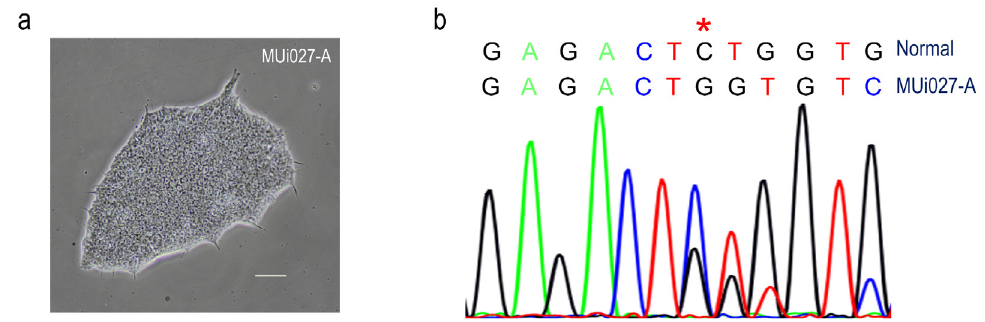
Figure 1. Generation of iPSC lines from ADPKD patient. ( a ) Representative bright field photograph of an iPS colony obtained from fibroblasts of a patient carrying PKD1 mutation. ( b ) DNA sequencing result from exon 21 of the PKD1 gene, showing 7946_7947delCT mutation. The asterisk symbol (*) indicates the position of frameshift mutation.